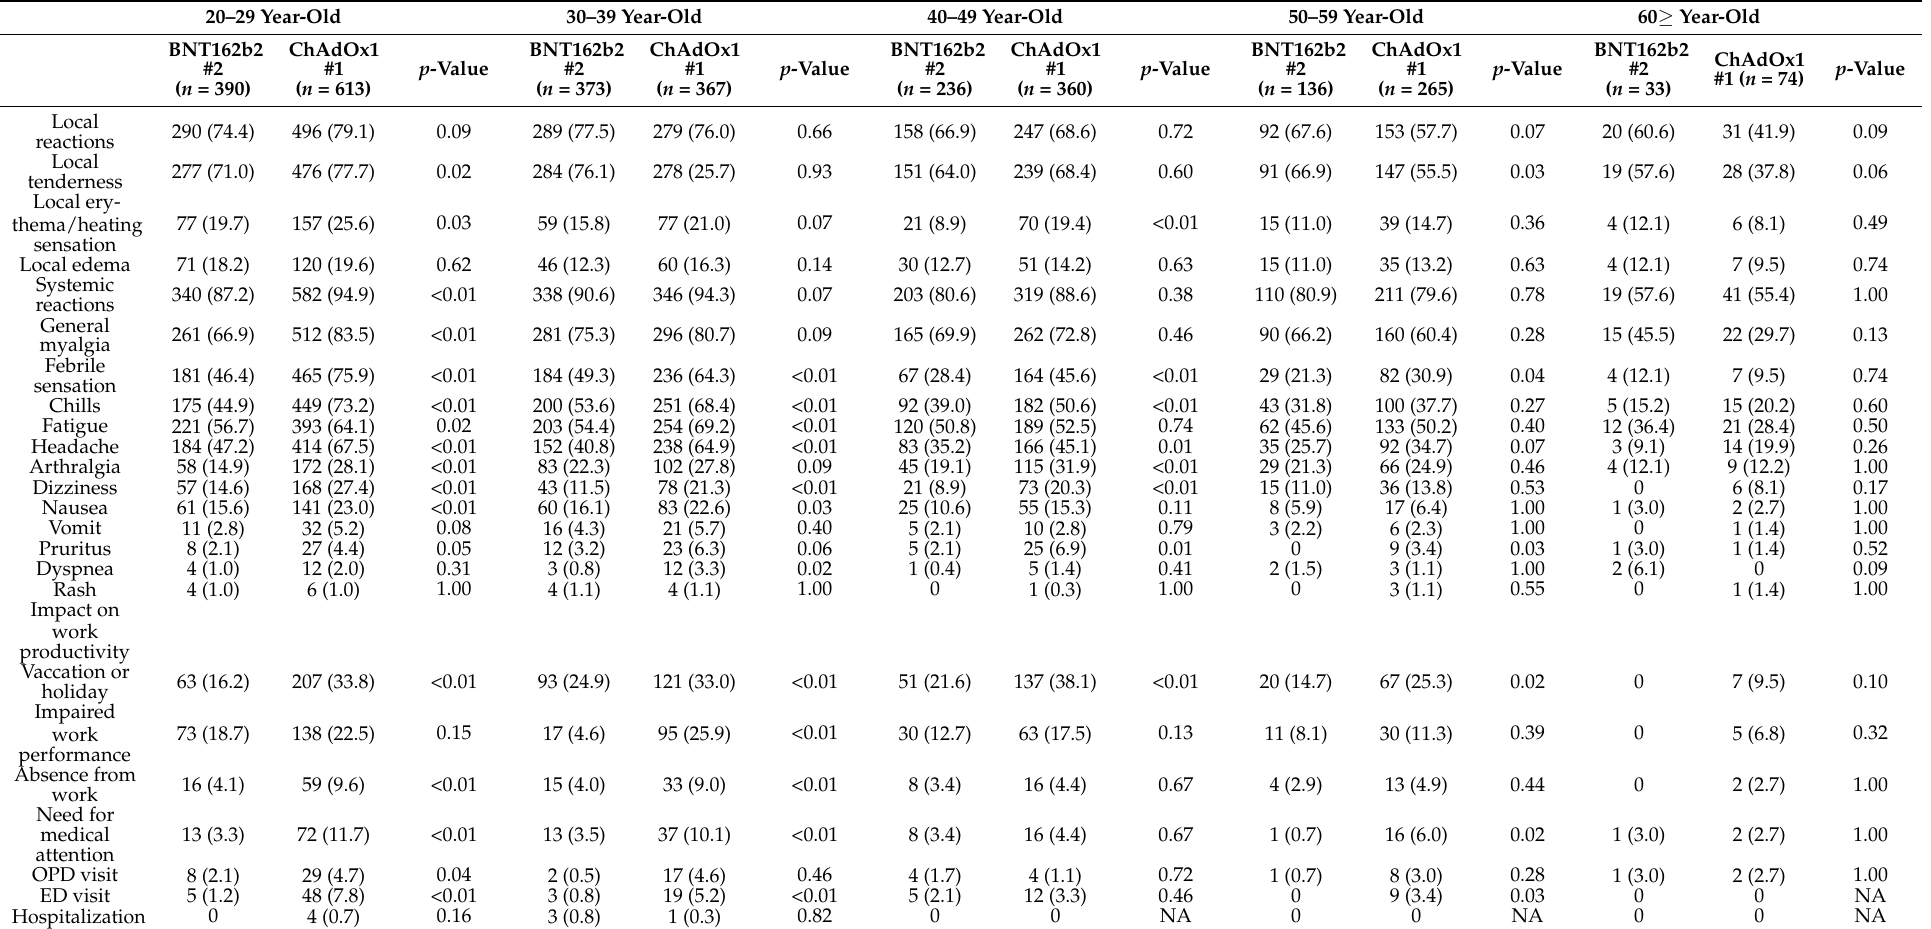
Table 2. Side effects and their impact on work productivity and need for medical attention after the second dose of BNT162b2 and the first dose of ChAdOx1 vaccination according to age